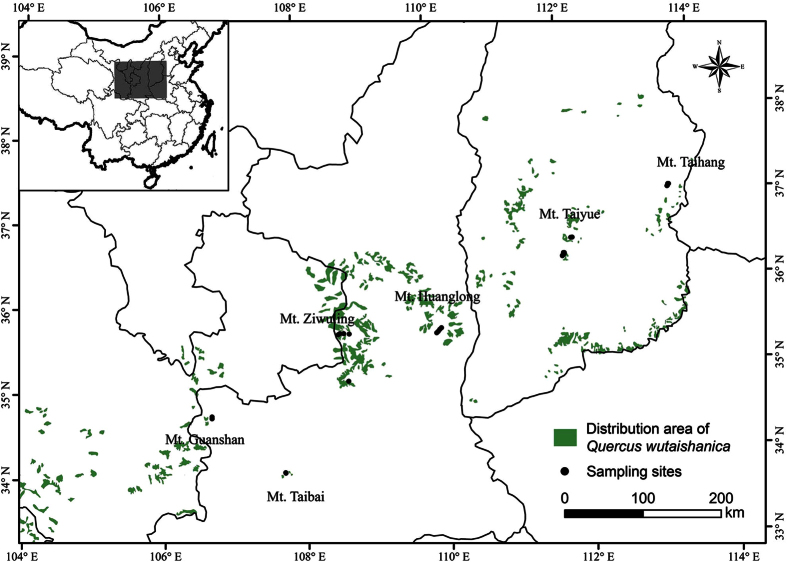
Locations of sampling sites.Black dots are location of sampling sites. Green-shaded portions are Quercus wutaishanica forest in the Loess Plateau. The map is made by ArcGIS 10.2 software, http://www.arcgis.com/features/.